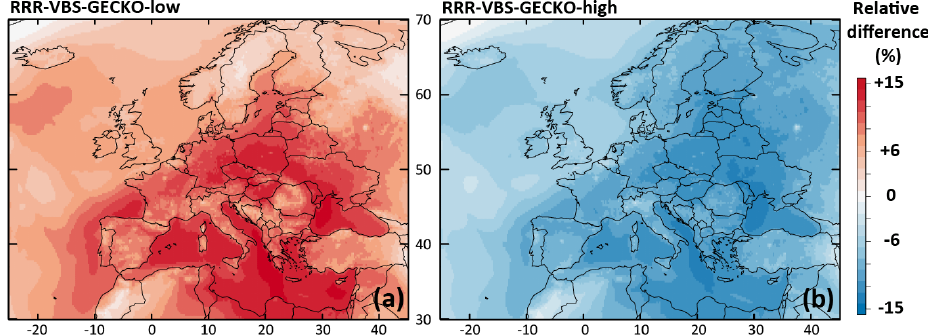
Figure 8. Relative differences on the simulated mean OA concentrations between (a) the RRR-VBS-GECKO-low and the ref-VBS-GECKO model configurations and (b) between the RRR-VBS-GECKO-high and the ref-VBS-GECKO model configurations for the 2-month